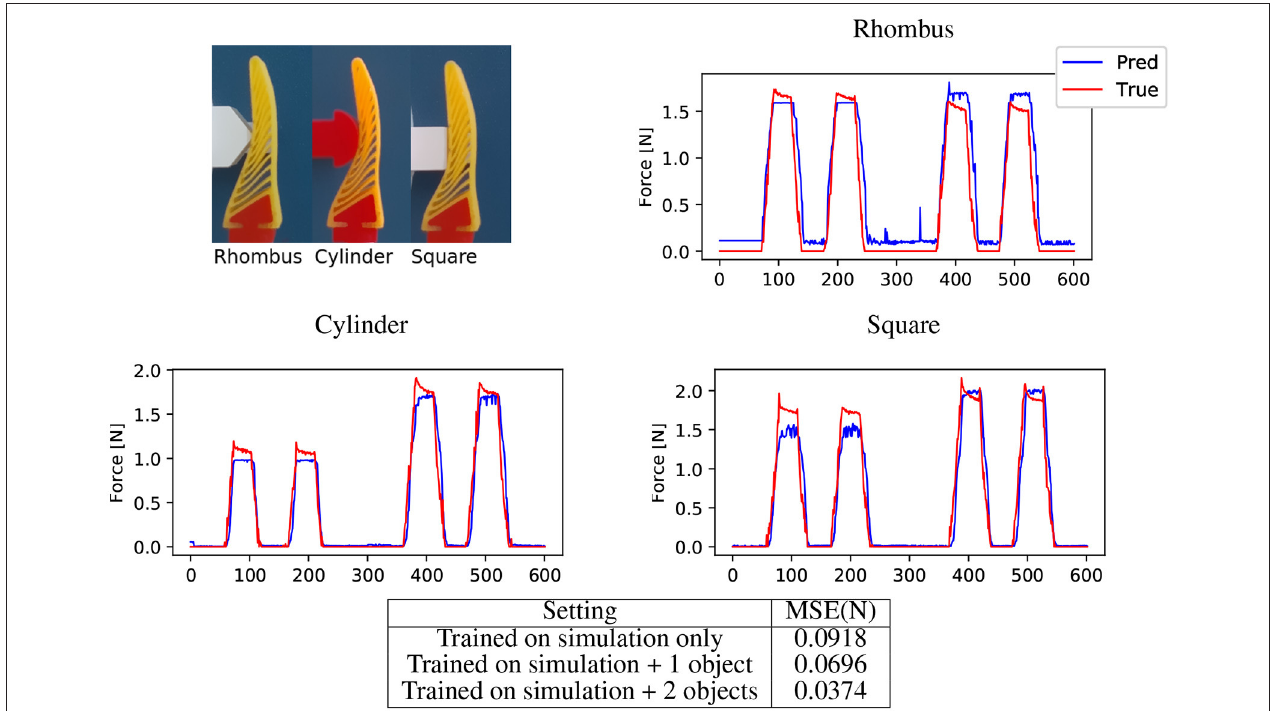
FIGURE 10 | Force prediction for real objects. (Top-left) Cropped input images showing three test objects. (Top-right, Middle-left, Middle-Right) Force predictions for rhombus, cylinder and square respectively by network trained on simulation data appended with cylinder, rhombus, and square as context object. We compare the predictions with the measurements obtained by the force sensor. Note the incorrect predictions (Top-right) in the absence of the force, this is due to the incorrect color segmentation. (Bottom) We here present the mean squared error in force on real data. While the network is able to generalise to real data, adding the context object reduces the domain gap and improves the prediction significantly. From the table, we can see that adding data form one object as context results in acceptable